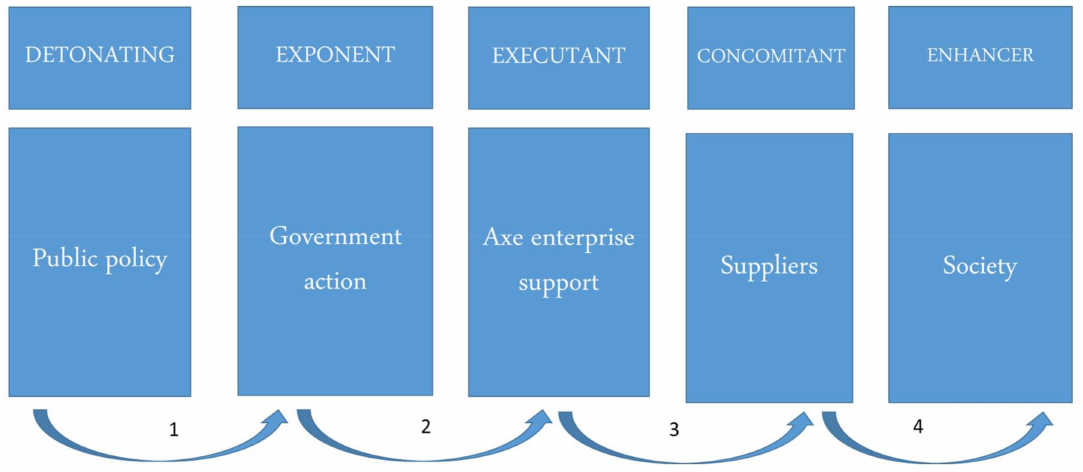
Figure 11. Sequential flow to enable the integration of suppliers. Source: author’s